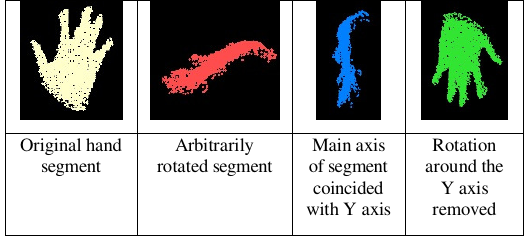
Figure 6. Example of rotation removal of a hand